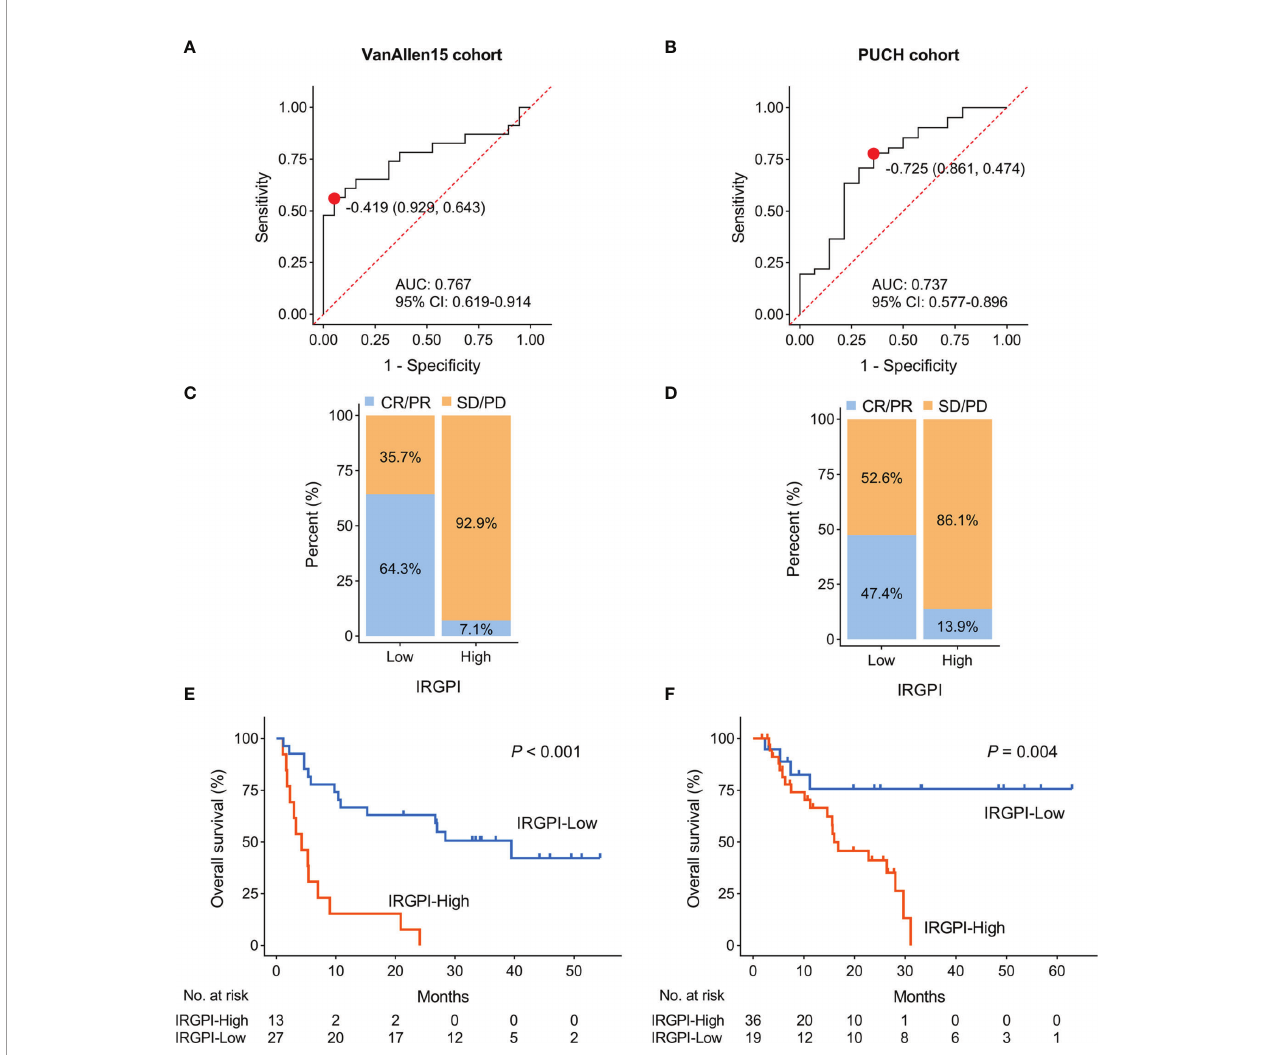
FIGURE 3 | Validation the performance of IRGPI in two cohorts. (A, B) ROC curves for the predictive performance of IRGPI in VanAllen15 and PUCH cohorts, respectively. (C, D) The rate of durable clinical response for patients with high and low IRGPI scores in VanAllen15 and PUCH cohorts, respectively. (E, F) Kaplan- Meier plots of overall survival segregated by IRGPI score with cut-off points selected according to the Youden index in VanAllen15 and PUCH cohorts, respectively. IRGPI, immune-related gene pair index; ROC, receiver operating characteristic; AUC, area under curve; CI, con fi dence